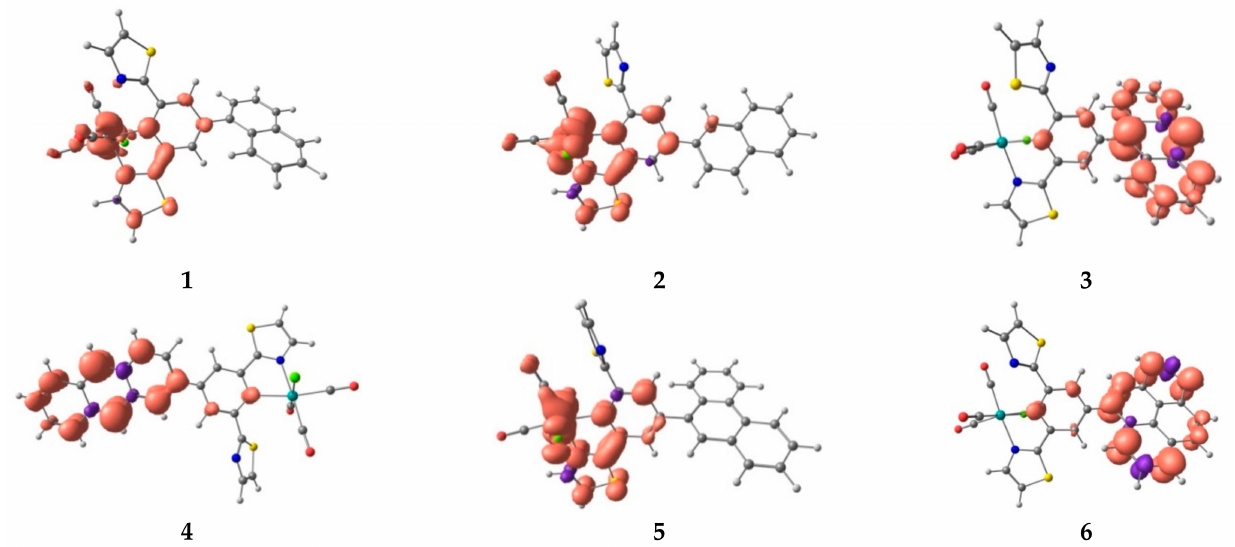
Figure 9. The energies of theoretical phosphorescence emissions, calculated from the difference between the ground singlet and the triplet state ∆ E T , along with the experimental values and the 1 − S 0 spin density surface plots for 1 – 6 . Orange and violet colours show regions of positive and negative spin density values,